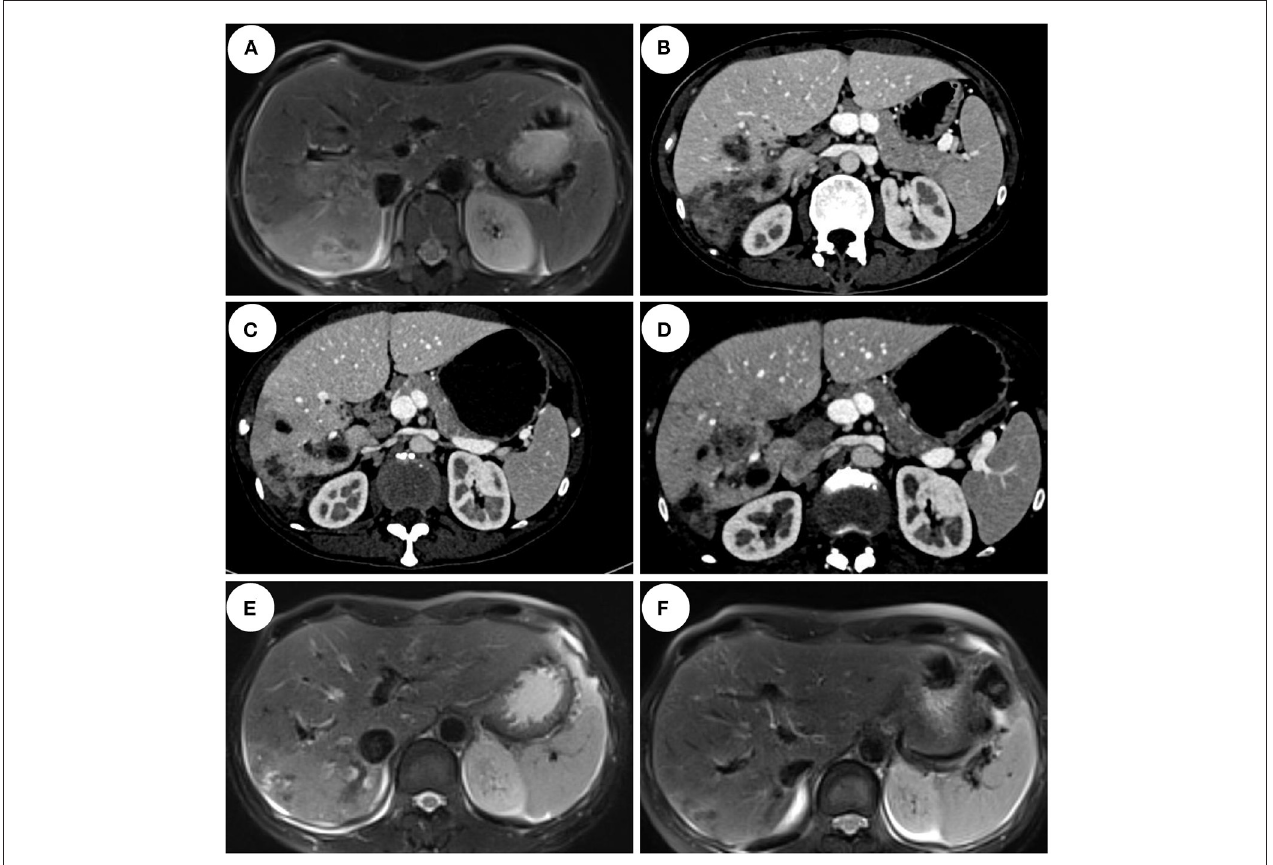
FIGURE 3 | Imaging features of the patient. (A) Abdominal MRI enhancement showed that the right lobe of the liver scattered flakes, irregular shape, enhanced uneven enhancement on hospital day 2. (B) Abdominal CT enhancement showed liver multiple nodules, mass slightly low-density shadow, edge enhancement on hospital day 13. (C) Abdominal CT enhancement showed multiple cystic and tubular low-density shadows scattered in the liver, and some showed edge enhancement on day 33. (D) Abdominal CT enhancement showed multiple cystic and tubular low-density shadows scattered in the liver, some showed edge enhancement, and a few lesions were smaller than those before on follow-up day 69. (E) Abdominal MRI enhancement showed cystic and tubular shadows in the right lobe of the liver, with irregular shapes and edge enhancement in the enhanced part. Some lesions were smaller than before on follow-up day 137. (F) Abdominal MRI enhancement showed the right lobe of the liver scattered flakes, irregular shape, enhanced edge uneven enhancement, lesions significantly reduced on follow-up day